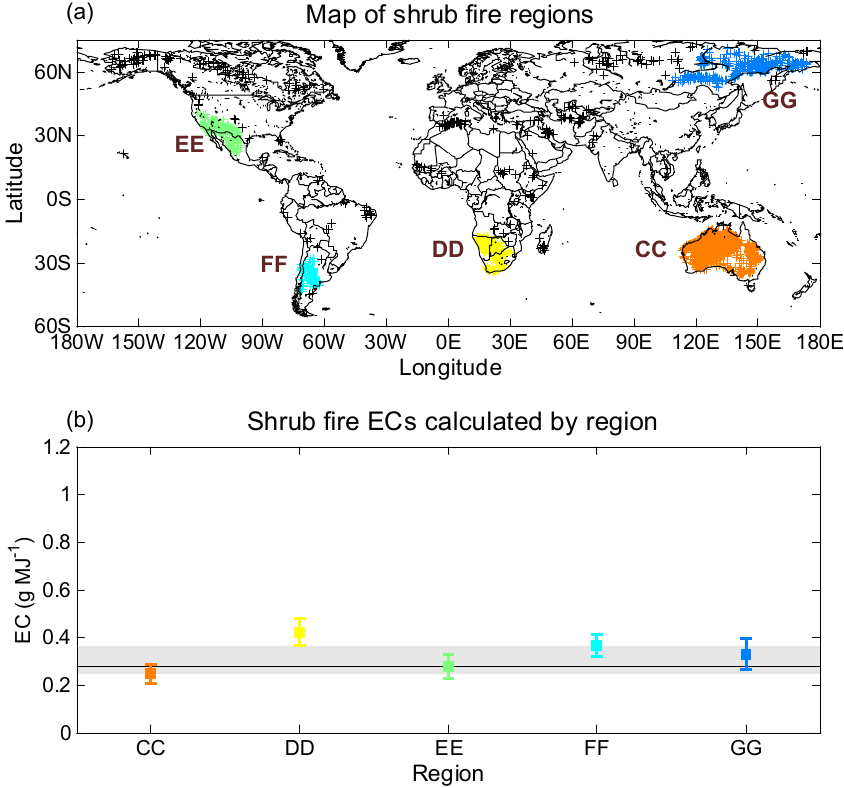
Fig. 5. A map of shrub fire regions determined by a clustering analysis (a) and ECs calculated individually for each region (b) . In (a) , black markers identify shrub fires belonging to clusters with less than 100 observations. In (b) , the mean shrubland biome EC is indicated by the black line, while the range of all mean biome ECs (as presented in Table 2) is indicated in